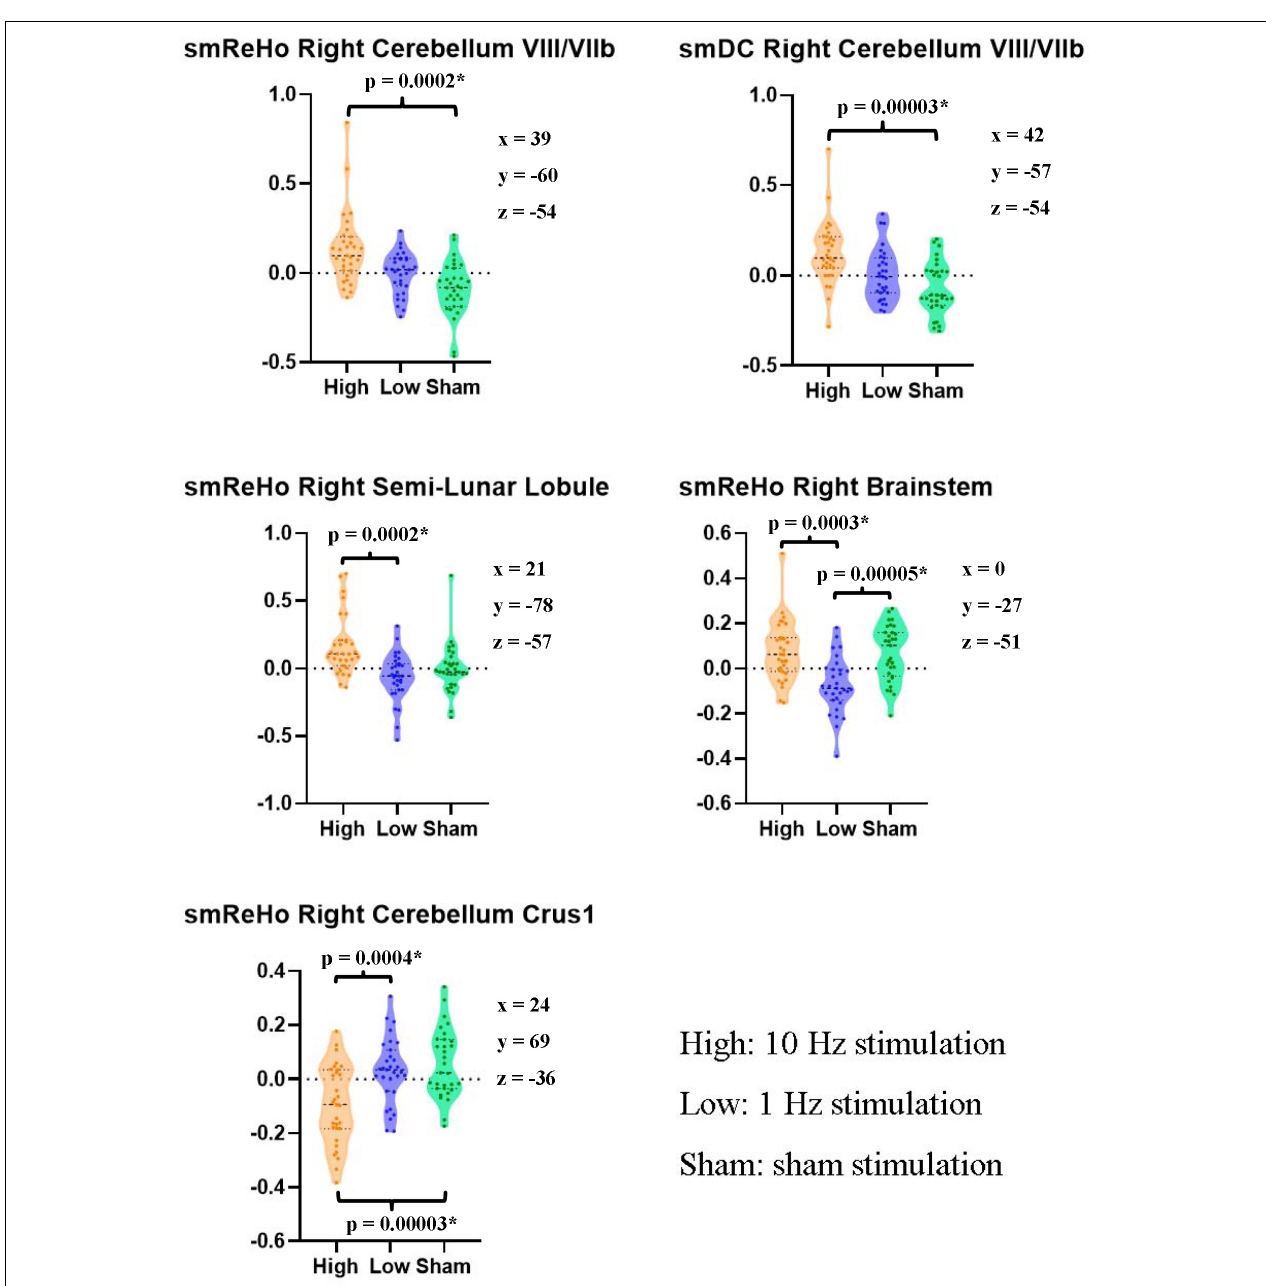
FIGURE 3 | Pairwise paired t tests between stimulation conditions on the ReHo and DC value of the peak voxel of F maps in the right cerebellum. The coordinates of the peak voxels were the same as Table 2 . *Still significant after Bonferroni correction of 0.05/15 = 0.0033.